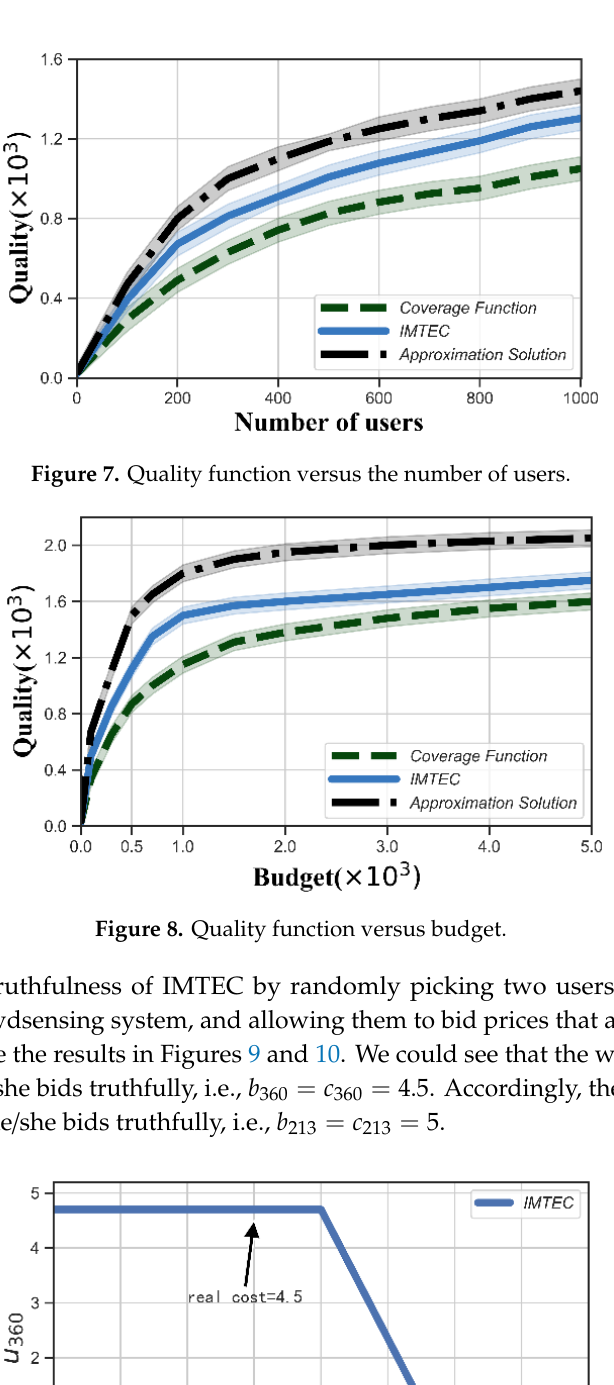
Figure 10. Utility of user with ID = 213 (loser).